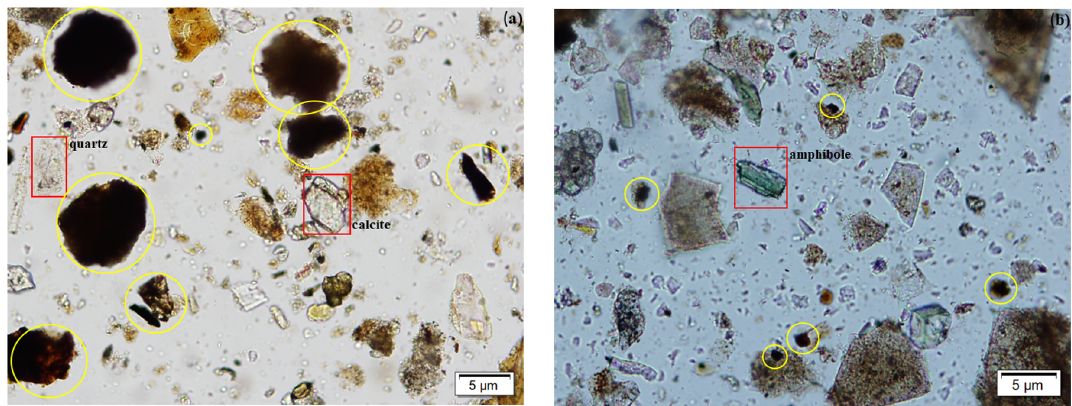
Figure 4. Panels (a) and (b) are OM images of representative samples S6 and S11, respectively, depicting the presence of quartz, calcite, amphiboles (red rectangles), and dark materials (yellow circles). Quantitative and visual assessments reveal that both images contain a high abundance of dark materials and other unknown particles that have no diagnostic mineral properties.